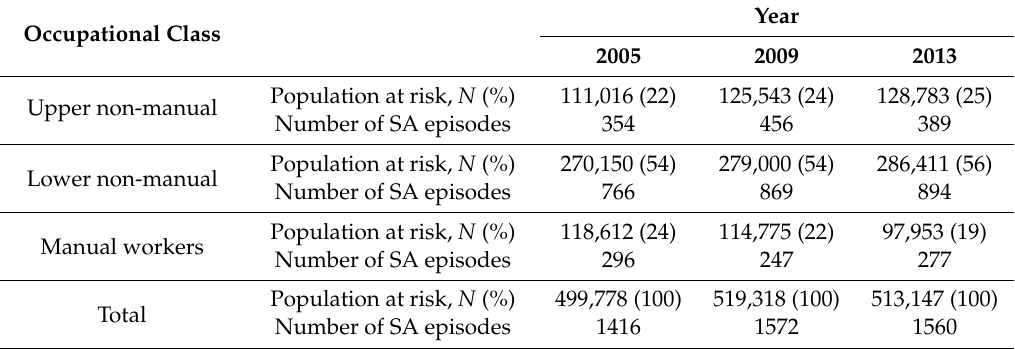
Table 1. Risk population and number of sickness absence (SA) episodes attributable to breast cancer by occupational